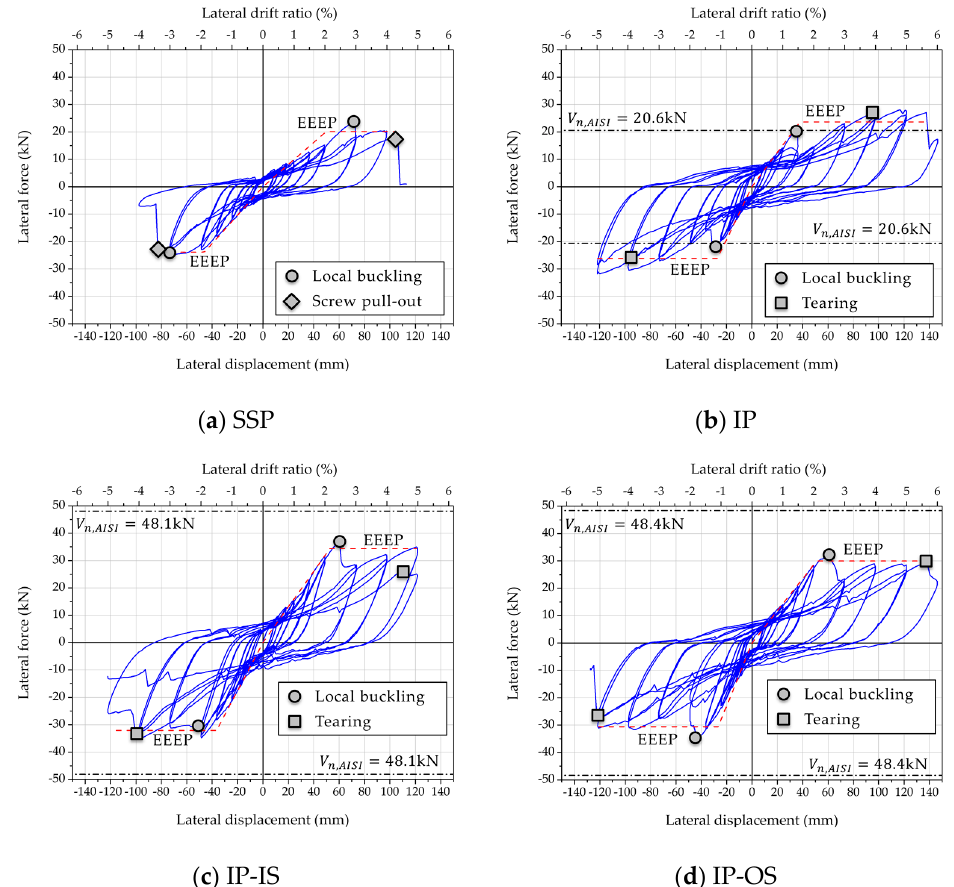
Figure 6. Lateral load–drift ratio relationships and failure modes of specimens: ( a ) The steel-sheathed panel (SSP) specimen, ( b ) The integrated panel-inner stud (IP) specimen, ( c ) The integrated panel-inner stud (IP-IS) specimen, ( d ) The integrated panel-outer stud (IP-OS)